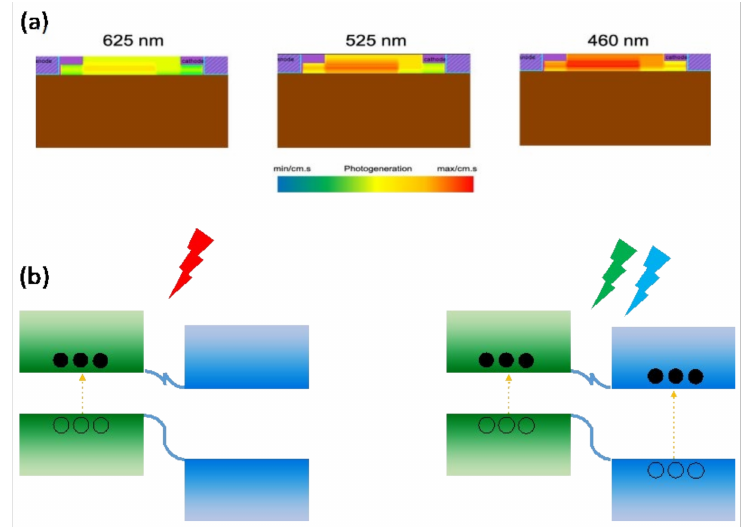
Figure 6. ( a ) Simulated photogeneratin at 625 nm, 525 nm and 460 nm wavelength. ( b ) Band diagram of device in light